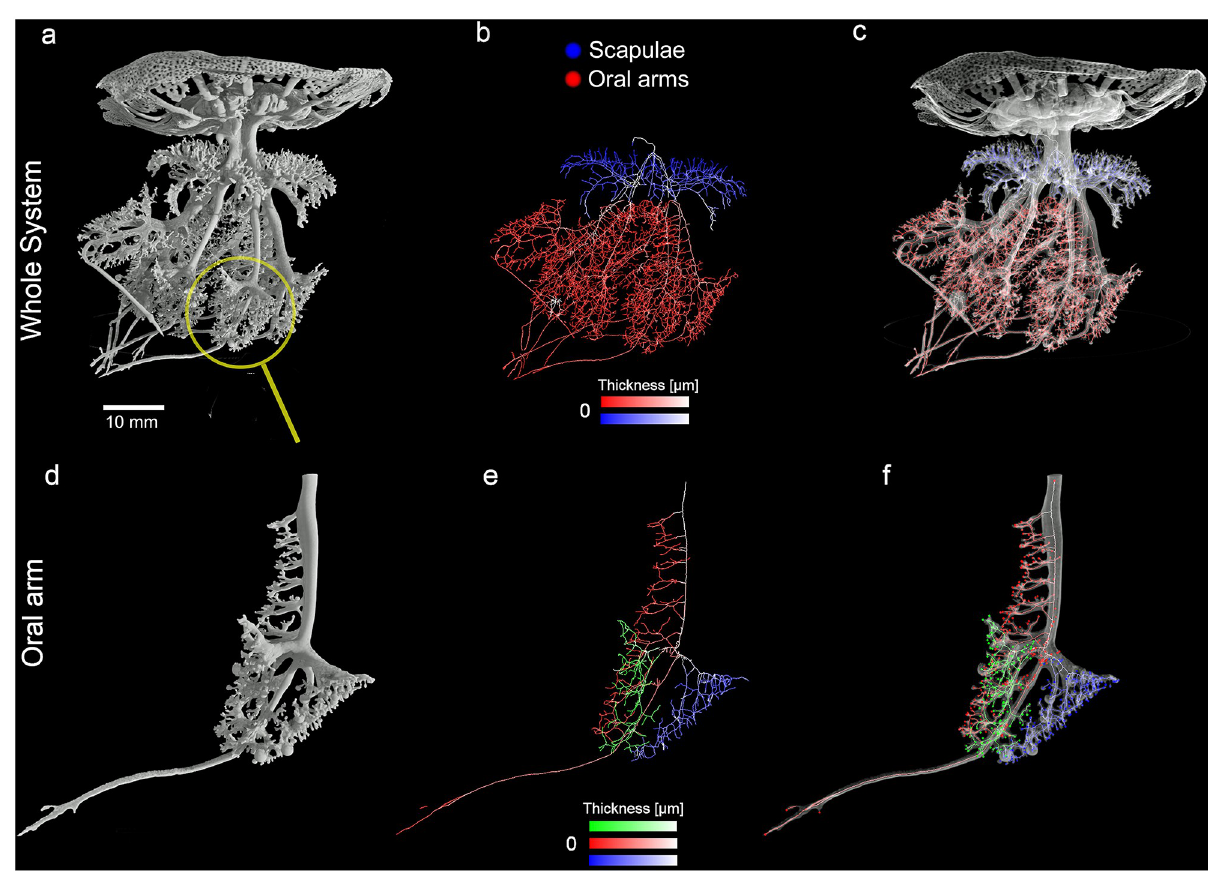
Fig 7. Graphical summary of the results of the quantitative analysis on the gastrovascular system. (a) 3D rendering of the whole cast of the gastrovascular system measured via X-ray μ CT. (b) Isosurface rendering showing the segmented gastrovascular system of the whole manubrium; false colors refer to the two different structures analyzed (blue = scapulae, red = oral arms). Color intensity is proportional to the local thickness values in the medial axis at that specific voxel. (c) Volume rendering of the cast; medial axes analysis, high intensity colors indicate the smaller canals. (d) Volume rendering of a single oral arm. (e) Thickness-labeled skeleton of the three-winged portions, each characterized by a specific hue (red, green, and blue). (f) Openings of the three different wings labeled with the three different colors as in (e). CT reconstruction performed with an isotropic voxel size of 62.0 μ